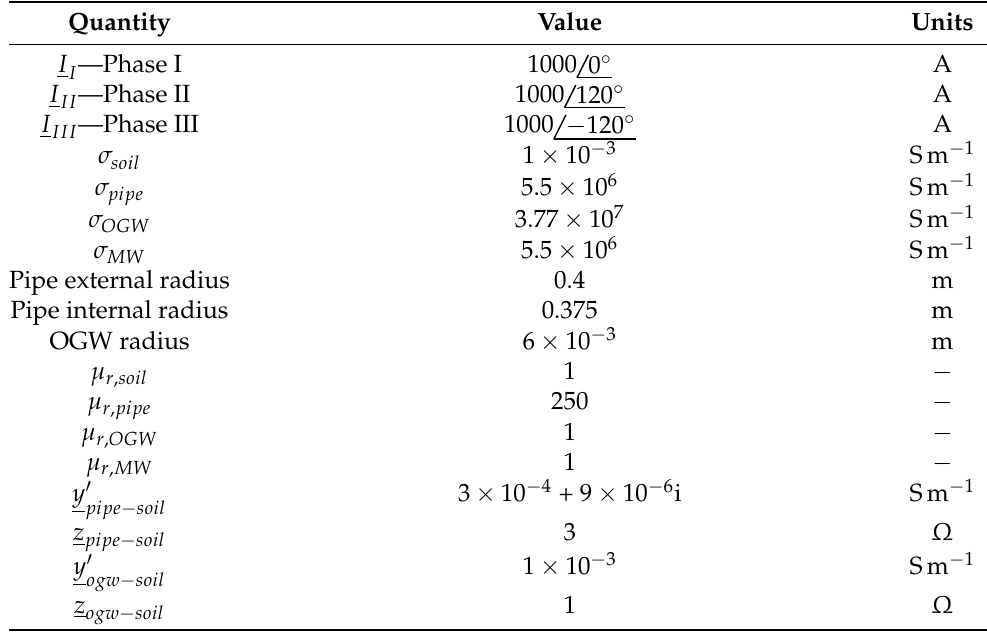
Table 1. Geometrical and electrical data.